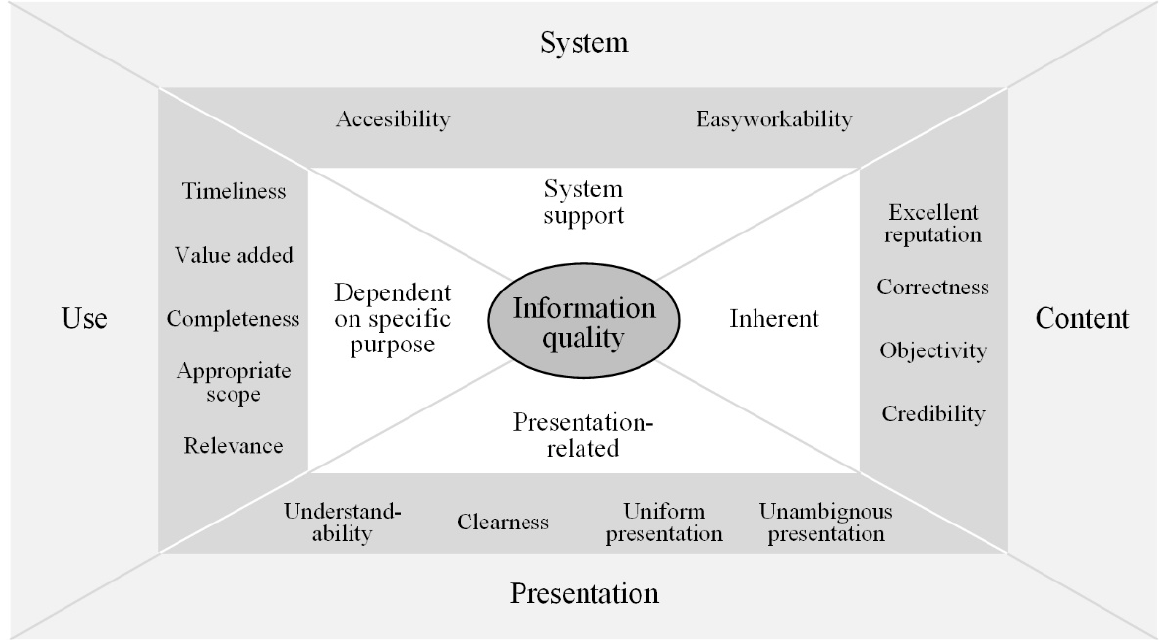
Figure 2. Definition of data quality criteria according to the proposal of the German Society for Information and Data Quality ref. to [35].